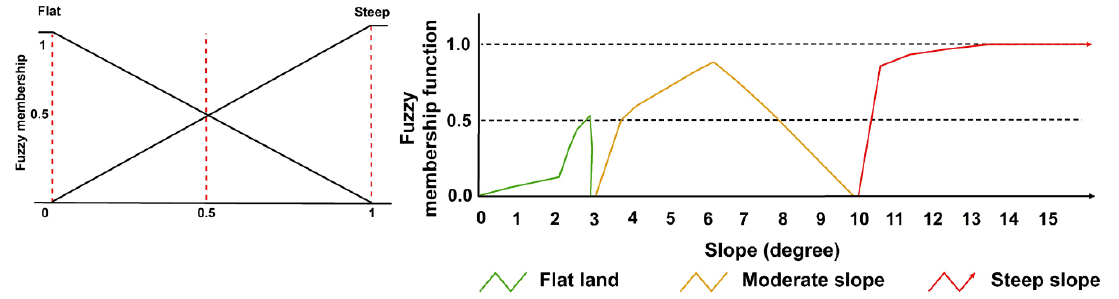
Figure 7. Fuzzy membership functions to determine the slope classes based on the 0 to 1 linear scale adapted from [40] ( left ), and assigned fuzzy membership values for slope in the study area ( right ).